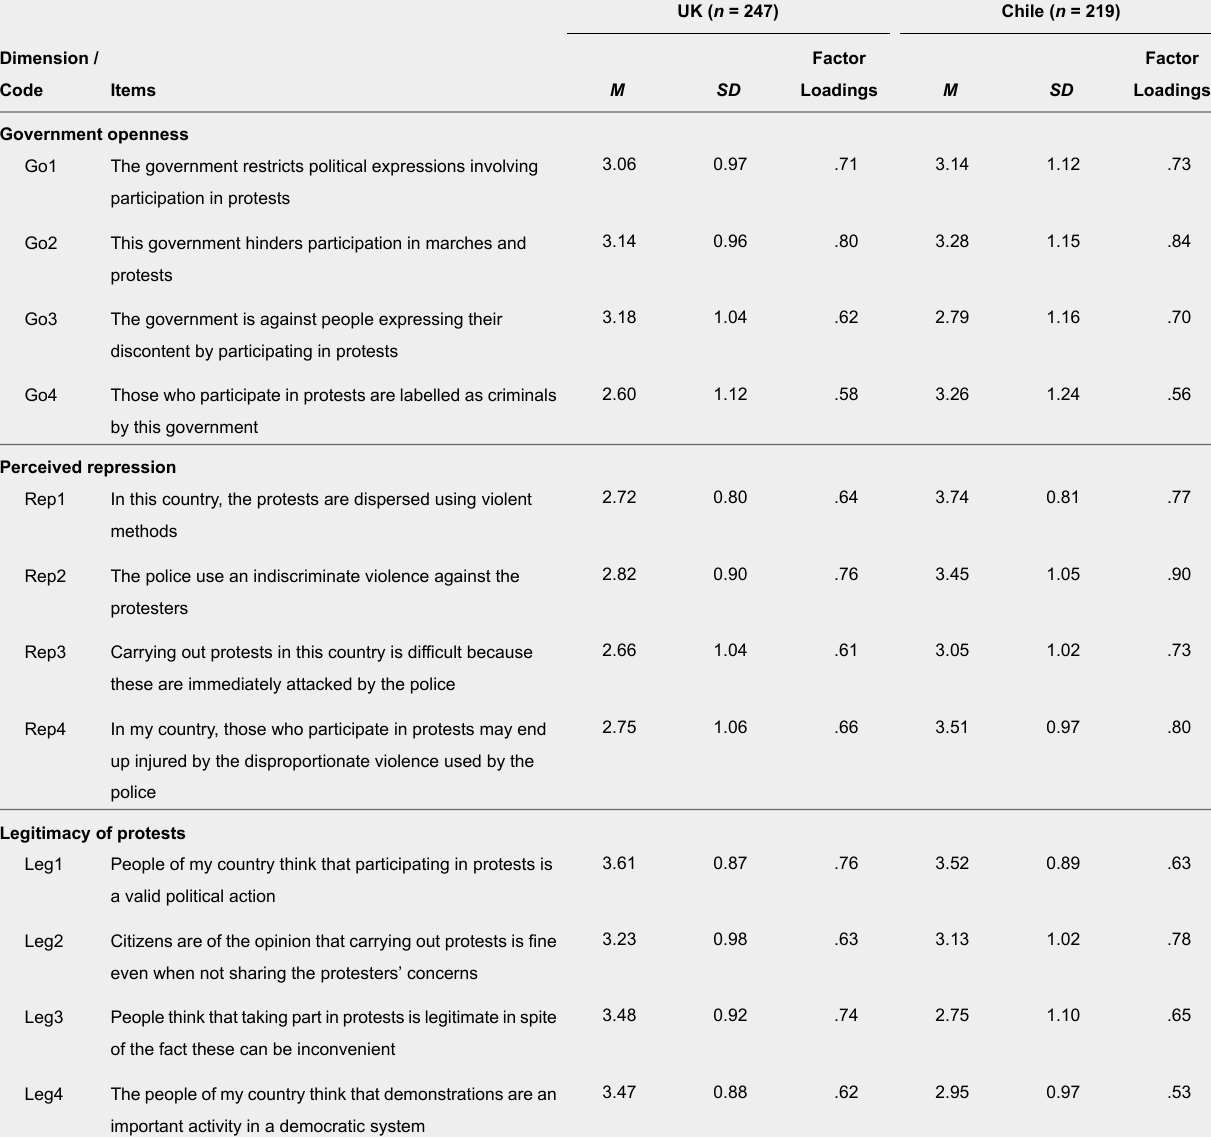
Descriptive Statistics and Standardised Factor Loadings of Items per